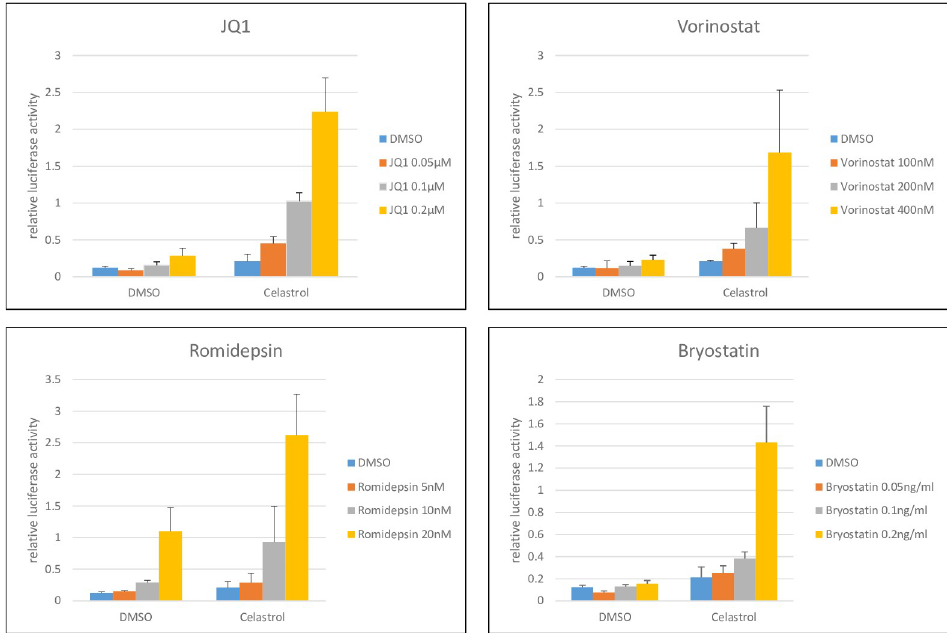
Fig 3. Reactivation of latent HIV-1 by combination of celastrol and LRAs in Jurkat 1G5 T cell line. 1G5 cells were treated with DMSO or 400 nM celastrol plus the indicated concentrations of vorinostat, romidepsin, JQ1, or bryostatin. Cell extracts were prepared at 24 hours post-treatment and Luciferase expression was normalized to amount of protein in cell extracts. Data are from three biological replicate experiments.